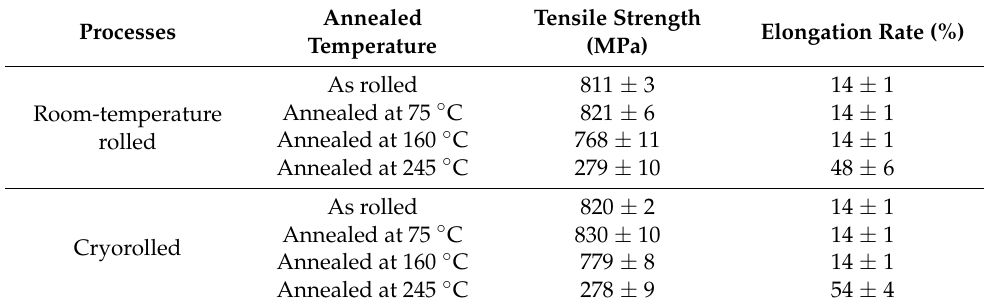
Figure 4. Tensile curves of sheets subjected to ( a ) room-temperature rolling and subsequent annealing, and ( b ) cryorolling and subsequent annealing. Table 1. Mechanical properties of pure nickel after room-temperature rolling, cryorolling, and subsequent